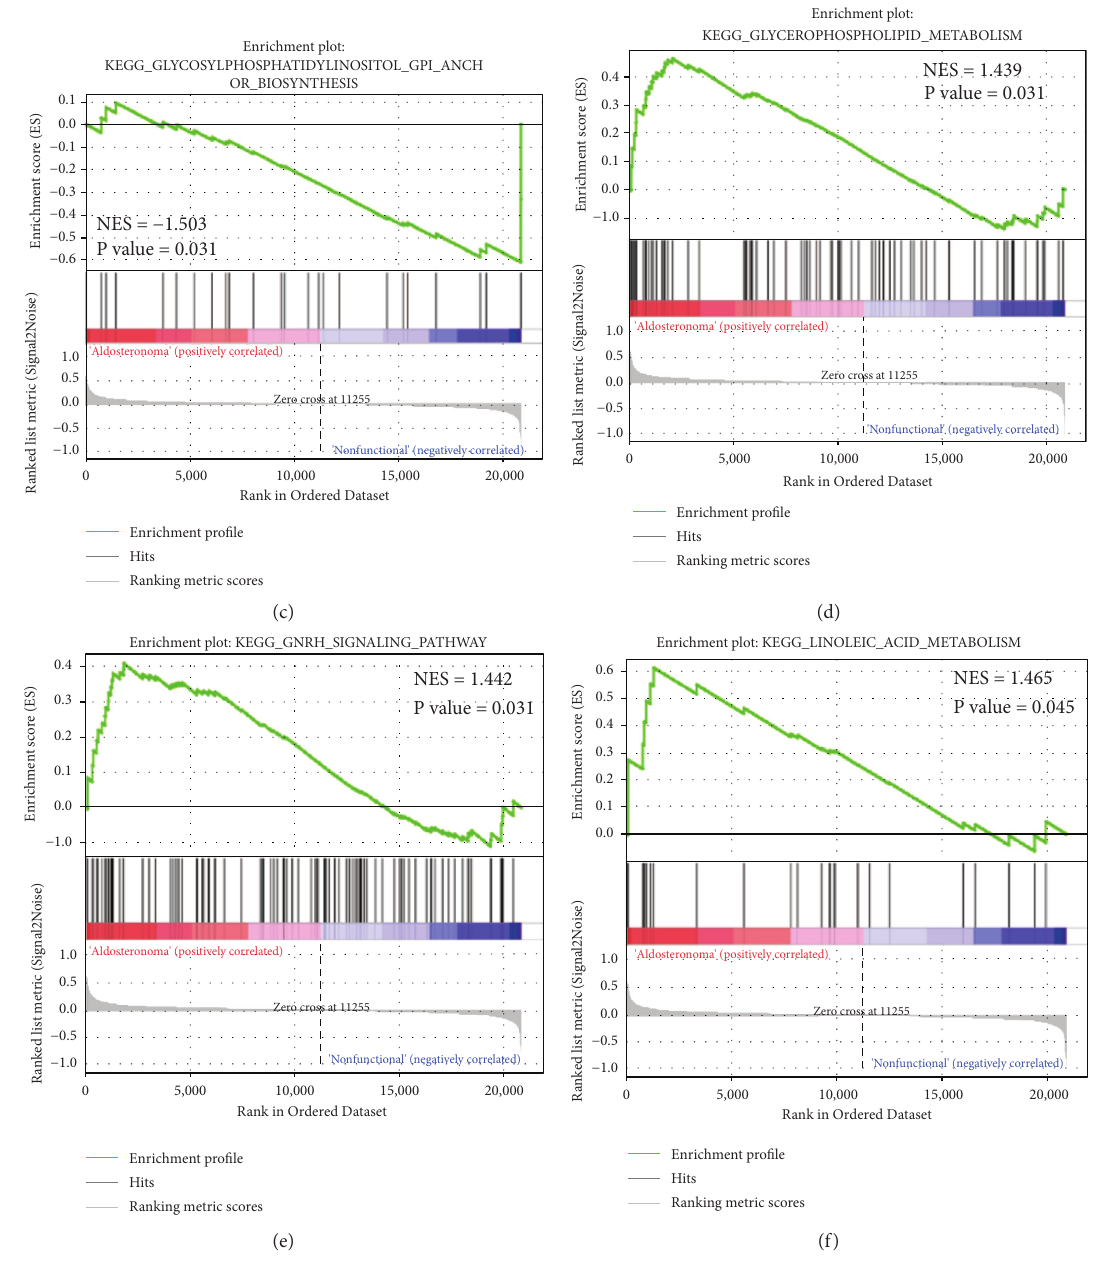
Figure 7: GSEA analysis for KEGG pathway enrichment using combined datasets. ABC, ATP-binding cassette; GPI, glyco- sylphosphatidylinositol; and GNRH, gonadotropin-releasing